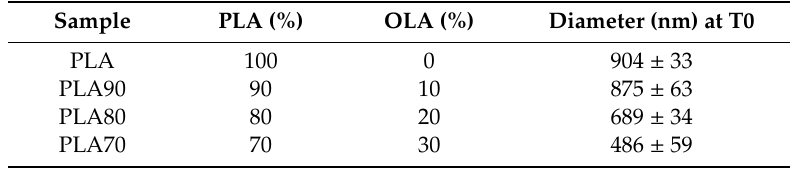
Table 1. PLA:OLA electrospun formulations and average diameter value of fibers at